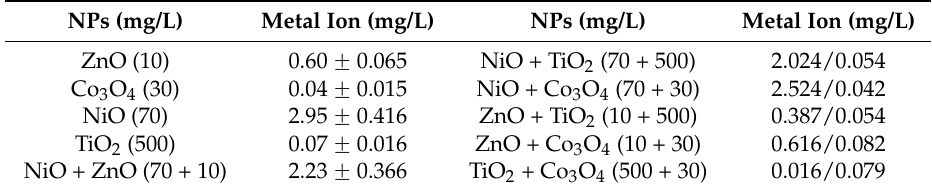
Table 2. Metal ion concentration in sandy soil slurry solution after 30 days of